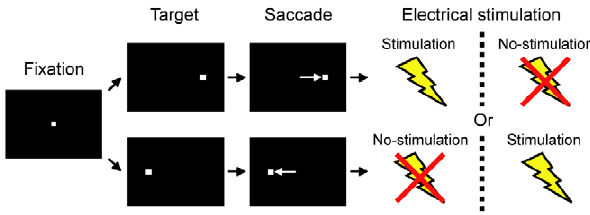
Figure 1. The visually guided saccade task. A trial started when a small fixation spot appeared on the screen. After the monkeys maintained fixation on the spot for 1200 ms, the fixation spot disappeared and a peripheral target appeared at either right or left. The monkeys were required to make a saccade to the target within 1000 ms. In one block of 36 trials, saccades to one fixed direction were followed by electrical stimulation of the LHb while saccades to the other direction were not. The direction-stimulation contingency was reversed in the next block.